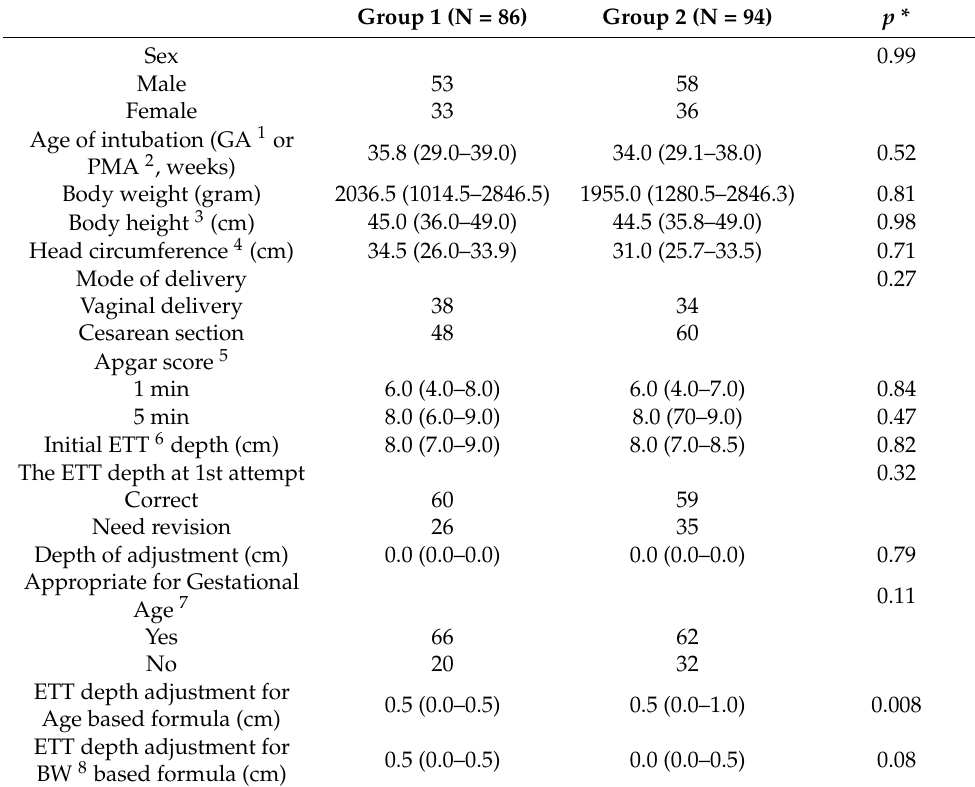
Table 3. Comparison of recommended endotracheal tube depth between two